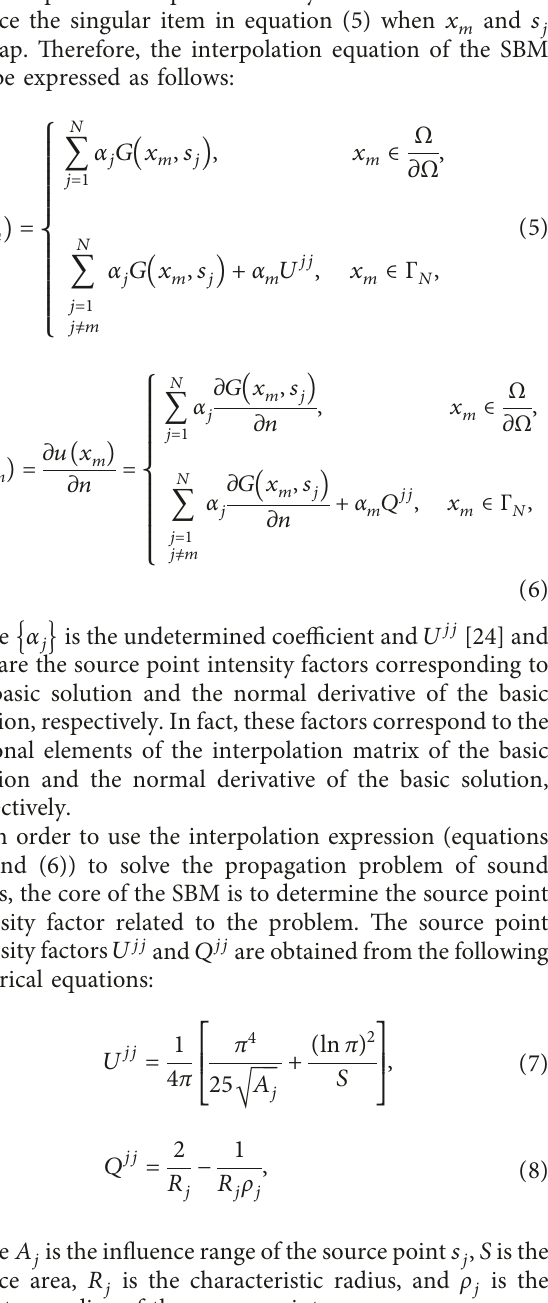
marker being in the same plane, the scattering effects of the three typical markers on the sound waves of 7, 10, and 14 kHz were simulated by the SBM. Figure 5 shows the calculated SPL of the three markers subjected to the sound waves of 7, 10, and 14